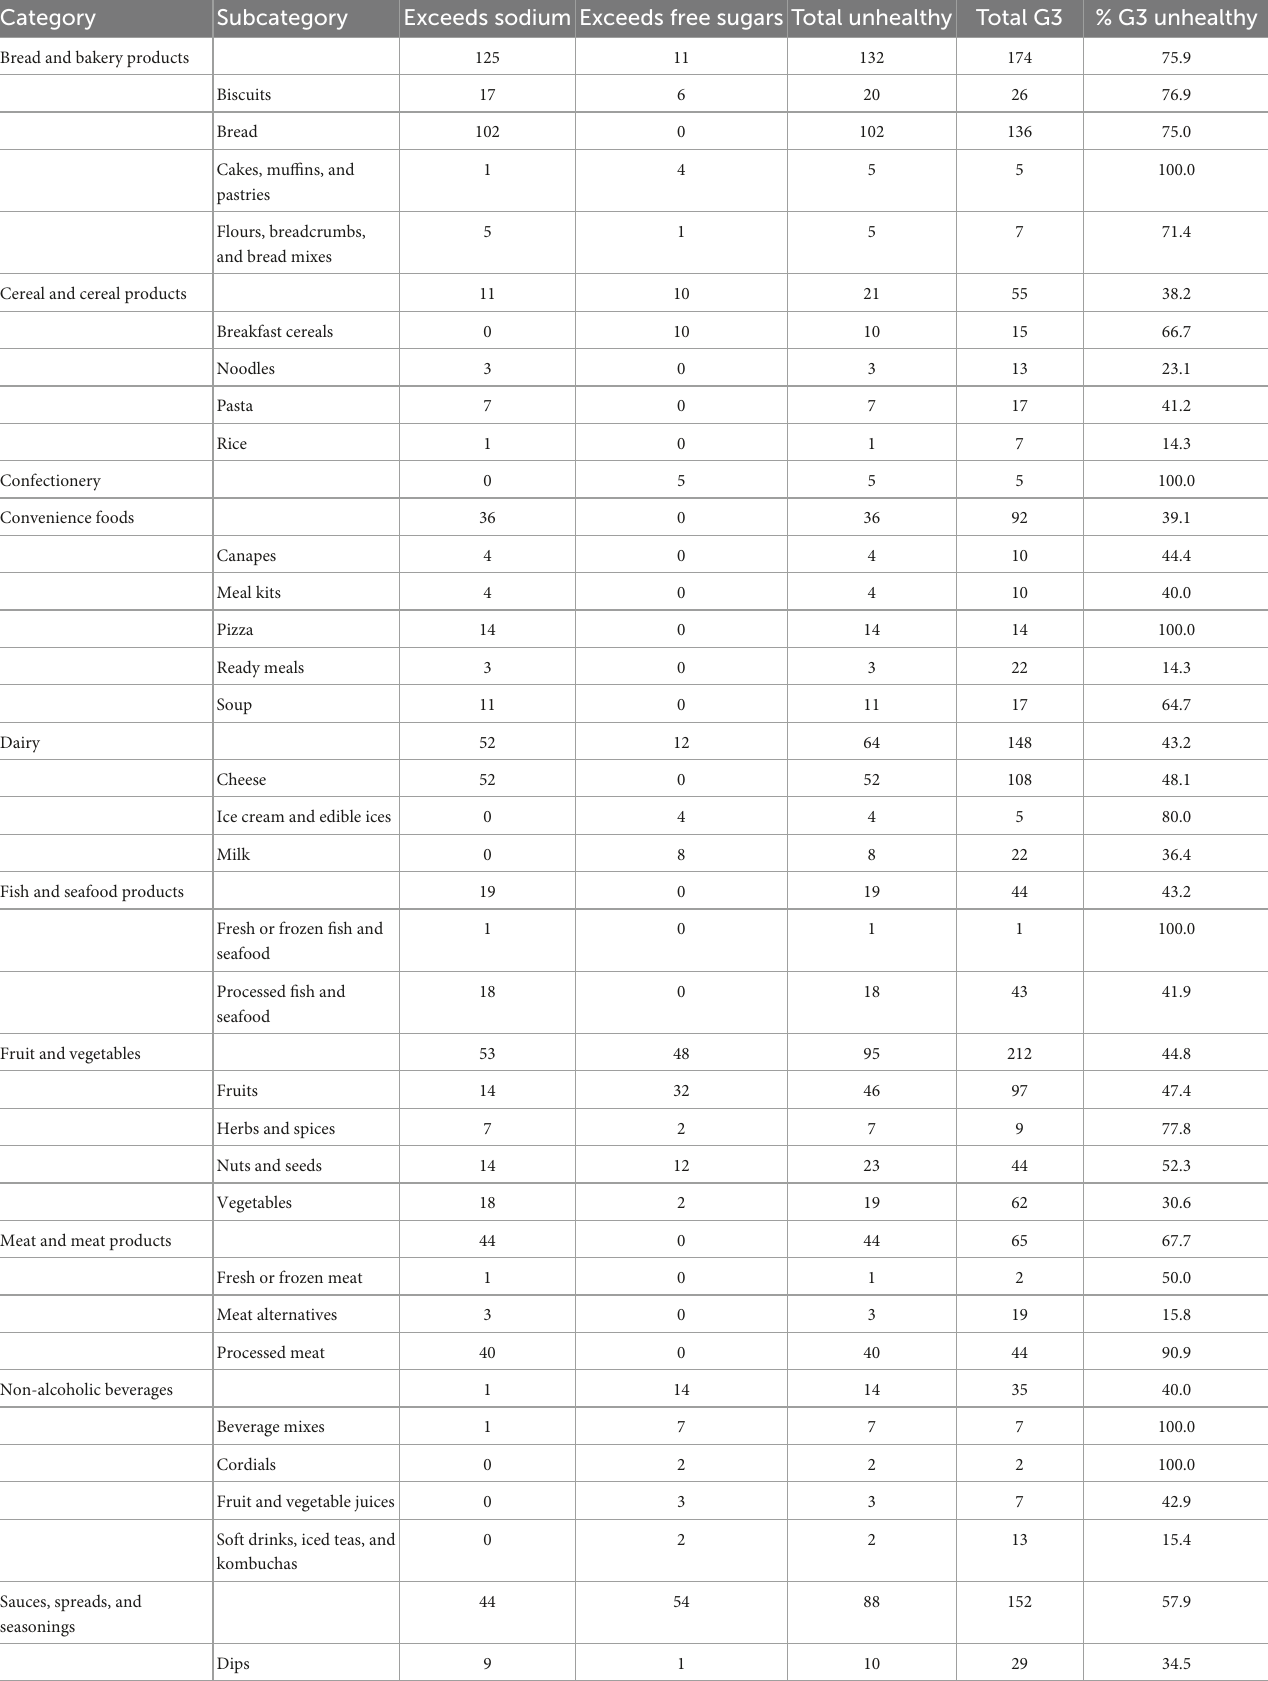
TABLE 4 Frequency of group 3 food items exceeding sodium and free sugar thresholds, and frequency and proportion classified as unhealthy, by category and subcategory.